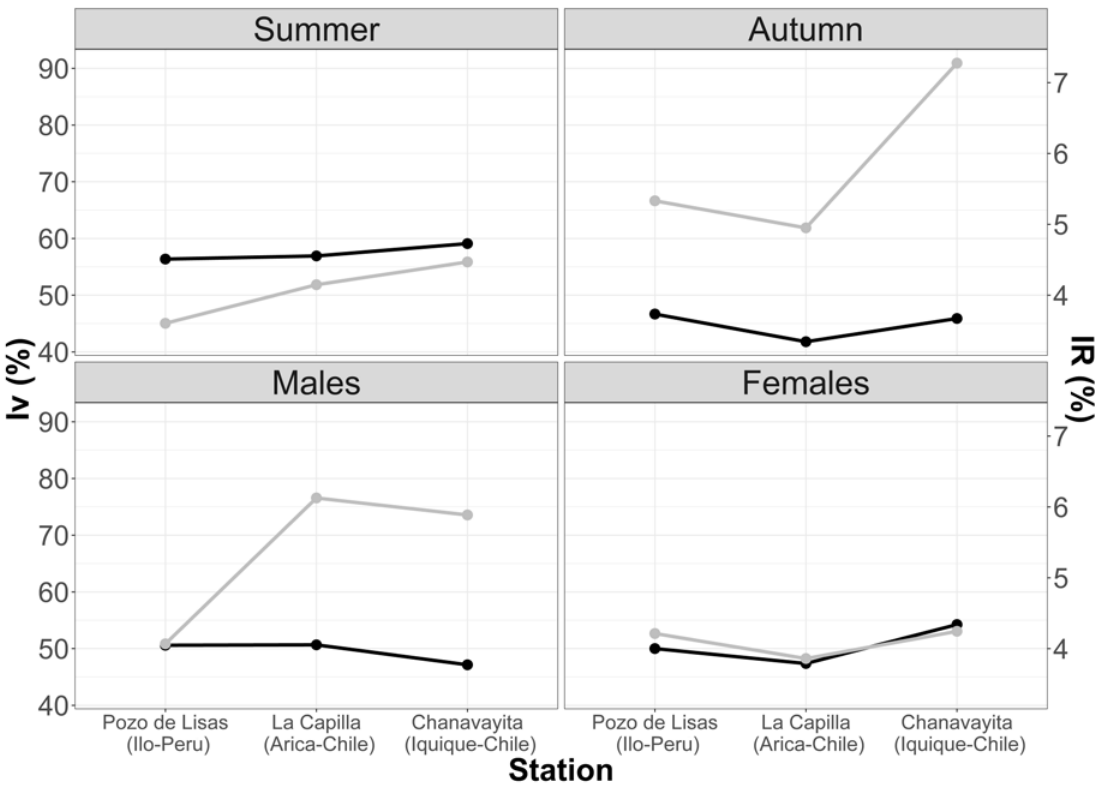
Figure 3. Variations in Mean Fullness and Vacuity Indexes with respect to seasons and sex. Black line (IV); grey line (IR).